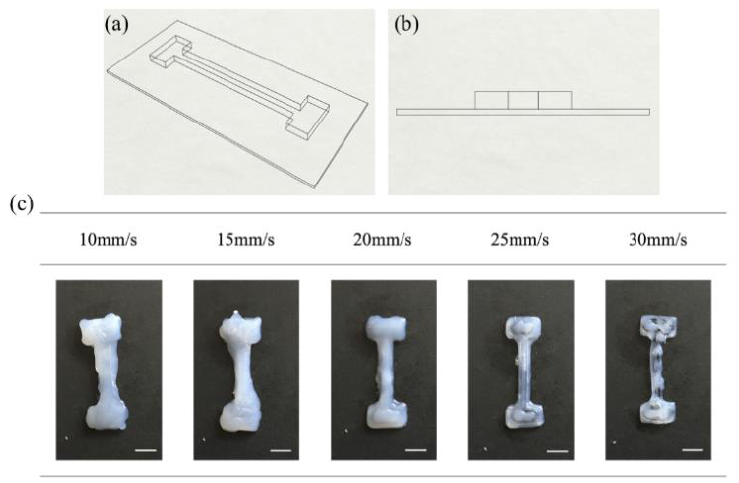
Figure 6. Schematic illustration of T bone: ( a ) overview and ( b ) side view. ( c ) Top view images of the 3D printed T bone under varied print speed. Scale bar: 1 cm.